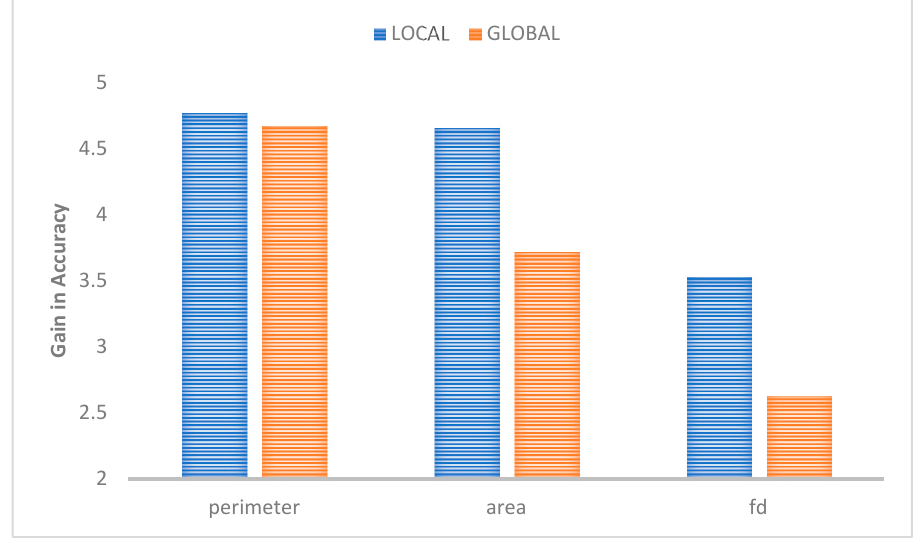
Figure 11. Feature importance of geometrical covariates, as derived from an XGBoost classifier, for the global and cutline segmentation-based approaches, respectively. The method used to derive importance is the gain in accuracy.